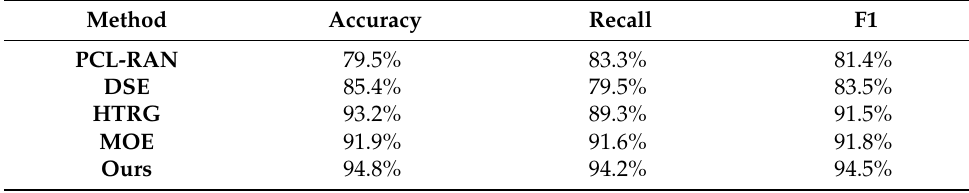
Table 3. Detection Results of Rock 1.